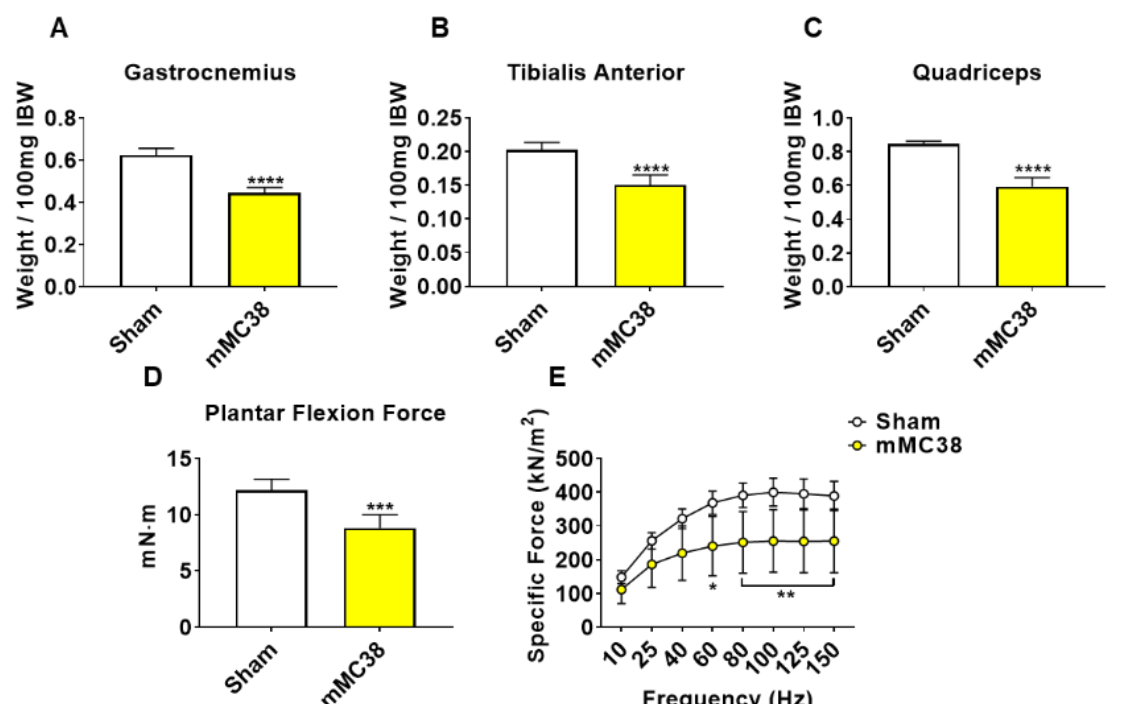
Figure 5. Formation of MC38 liver metastases heightens muscle wasting and weakness. ( A – C ) Gastrocnemius ( A ), tibialis anterior ( B ) and quadriceps ( C ) weights normalized to initial body weight (IBW) of C57BL/6 male mice (8 weeks) intrasplenically injected with MC38 tumor cells (1.25 × 10 5 cells/mouse in sterile PBS: mMC38) or an equal volume of vehicle (sham) ( n = 5–8). In vivo plantarflexion force assessment reported as absolute force (expressed as mN · m) ( D ). Assessment of ex vivo muscle contractility of EDL muscles, reported as specific ex vivo force (expressed as kN/m 2 ) ( E ). Data presented as mean ± s.d. * p < 0.05, ** p < 0.01, *** p < 0.001, **** p < 0.0001 vs. sham.